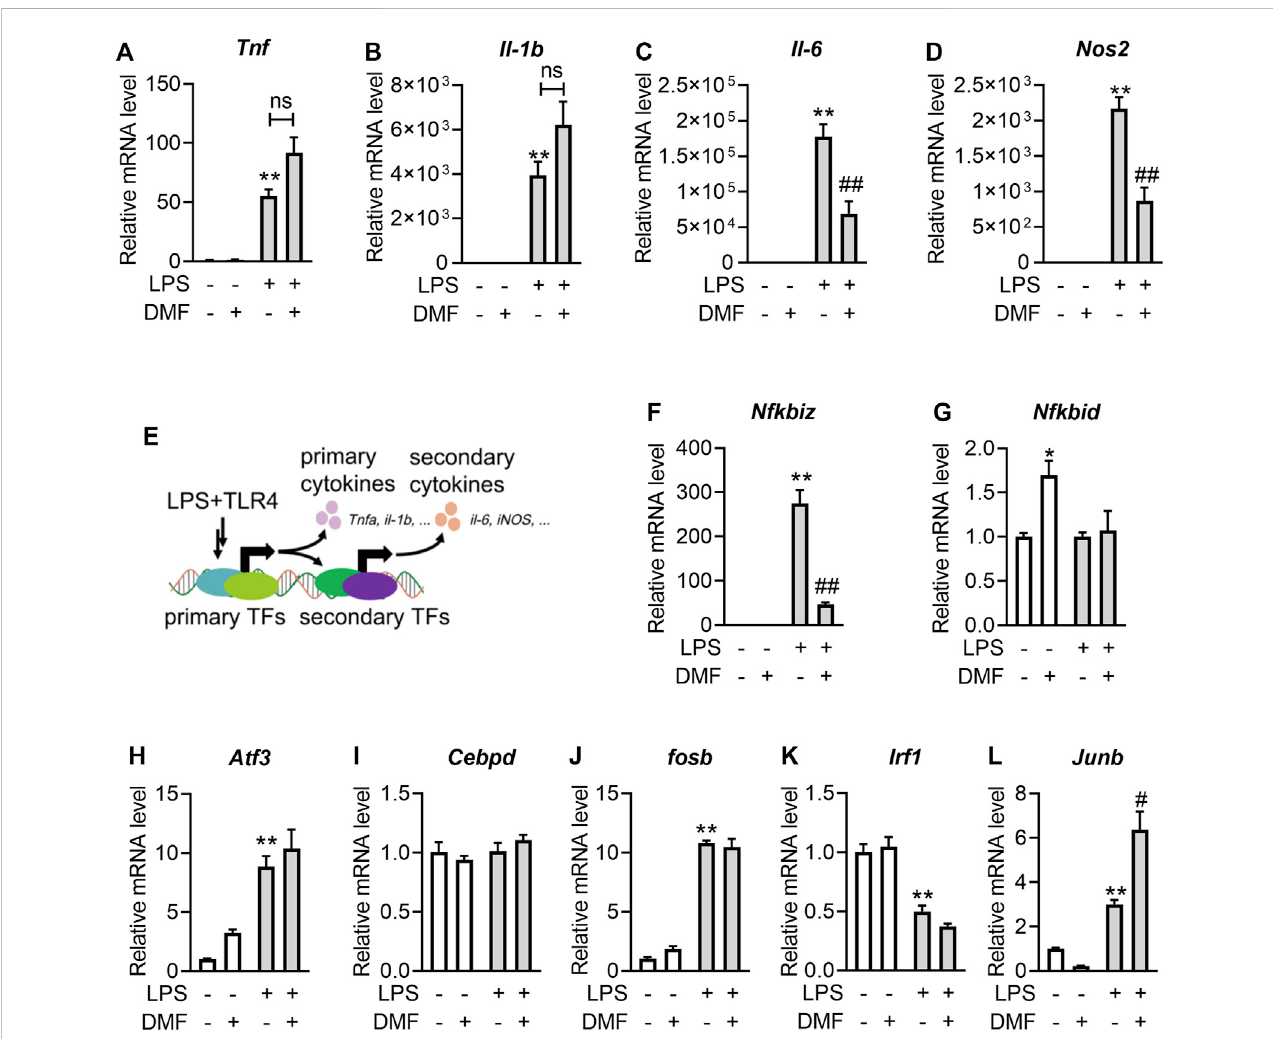
FIGURE 2 Short-termexposuretoDMFsuppressed thetranscriptionlevelofI κ B ζ inRAW264.7cells. (A – D) RAW264.7cellswerepretreatedwith40 μ MDMFfor1 h and then stimulated with 1 μ g/mL LPS in the absence of DMF for 6 h. RT ‒ qPCR analysis of Tnf (A) , Il-b (B) , Il-6 (C) and Nos2 (D) mRNA expression in the indicated groups ( n = 3). (E) Diagram of the primary and secondary transnational programs in the LPS/TRL4 pathway. (F – L) RAW264.7 cells were pretreated with 40 μ M DMF for 1 h and then stimulated with 1 μ g/mL LPS in the absence of DMF for 1 h. RT ‒ qPCR analysis of Nfkbiz (F) , Nfkbid (G) , Atf3 (H) , Cebpd (I) , Fosb (J) , Irf1 (K) and Junb (L) mRNAexpressionintheindicatedgroups( n =3).** p < 0.01 vs.theuntreatedgroupbyone-wayANOVA; ## p < 0.01 vs.theLPS group by one-way ANOVA; ns, not signi fi cant vs. the indicated group by t